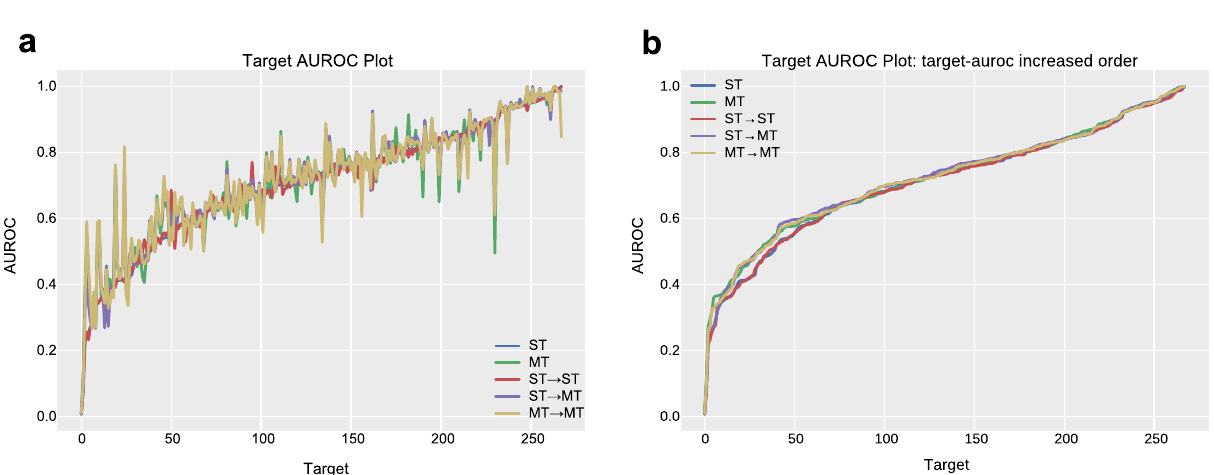
Figure 3. AUROC plot for the single-task model, multi-task model and knowledge distillation models. The blue line is a plot for the single-task learning model, and the green line is for the multi-task learning model. The red line is a plot for the single-task learning model distilled from the single-task learning model. The purple line plots the multi-task learning model distilled from the single-task learning model. The yellow line is a plot for the multi-task learning model distilled from the multi-task learning model. ( a) The target order is the same in the five plots. ( b) The target order of the five plots differs. The targets are ordered in target-AUROC increasing